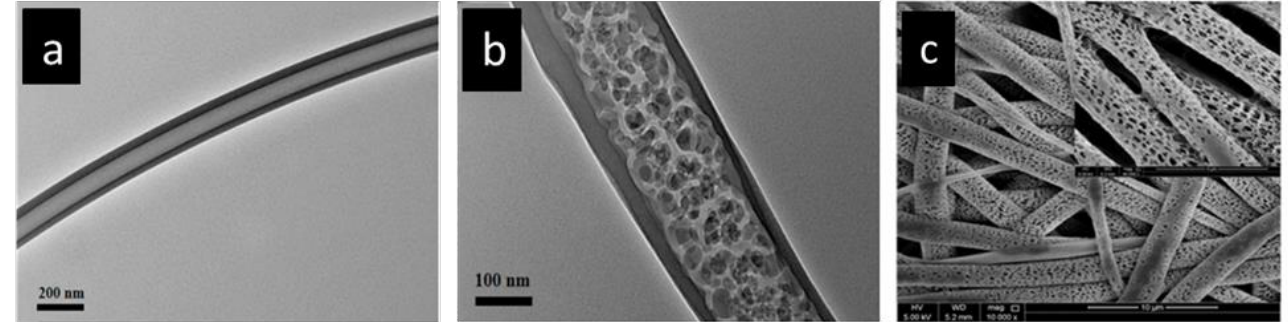
Figure 12. TEM images of core–shell nanofibers: ( a ) with compact core structure; ( b ) with porous core structure Reproduced with permission from [6] (License number: 5232520656228), ( c ) SEM image of coaxial PLA-PVA-CTGF membranes, reproduced from an open access paper [91] distrib- uted under the terms of the Creative Commons Attribution — Non-Commercial (v3.0) License.